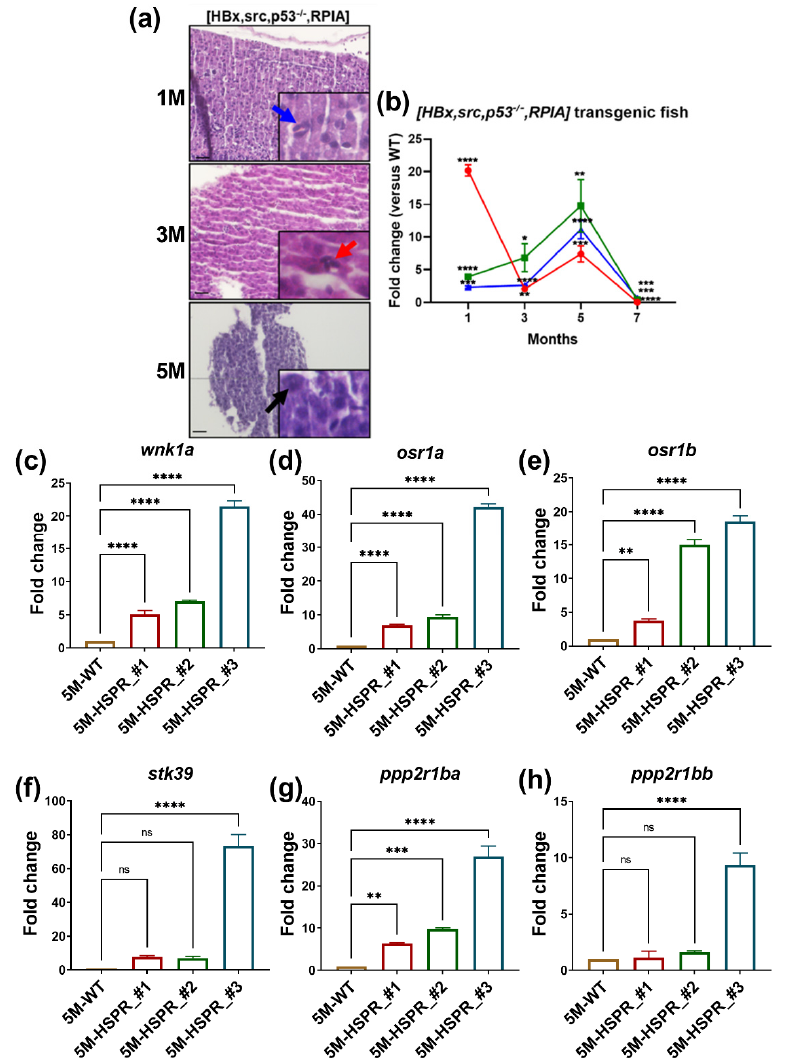
Figure 7. H&E stain and QPCR analysis reveal that [ HBx,src,p53 − / − ,RPIA ] transgenic fish developed HCC at 5 months of age. ( a ) The representative images of H&E staining of 1, 3, 5M